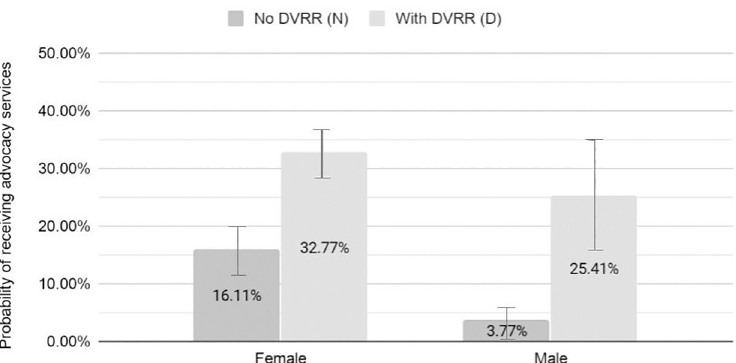
Fig 3. Predicted probability (95% CI) of follow-up advocacy services by DVRR status and sex. (see S1 Appendix for detailed results).